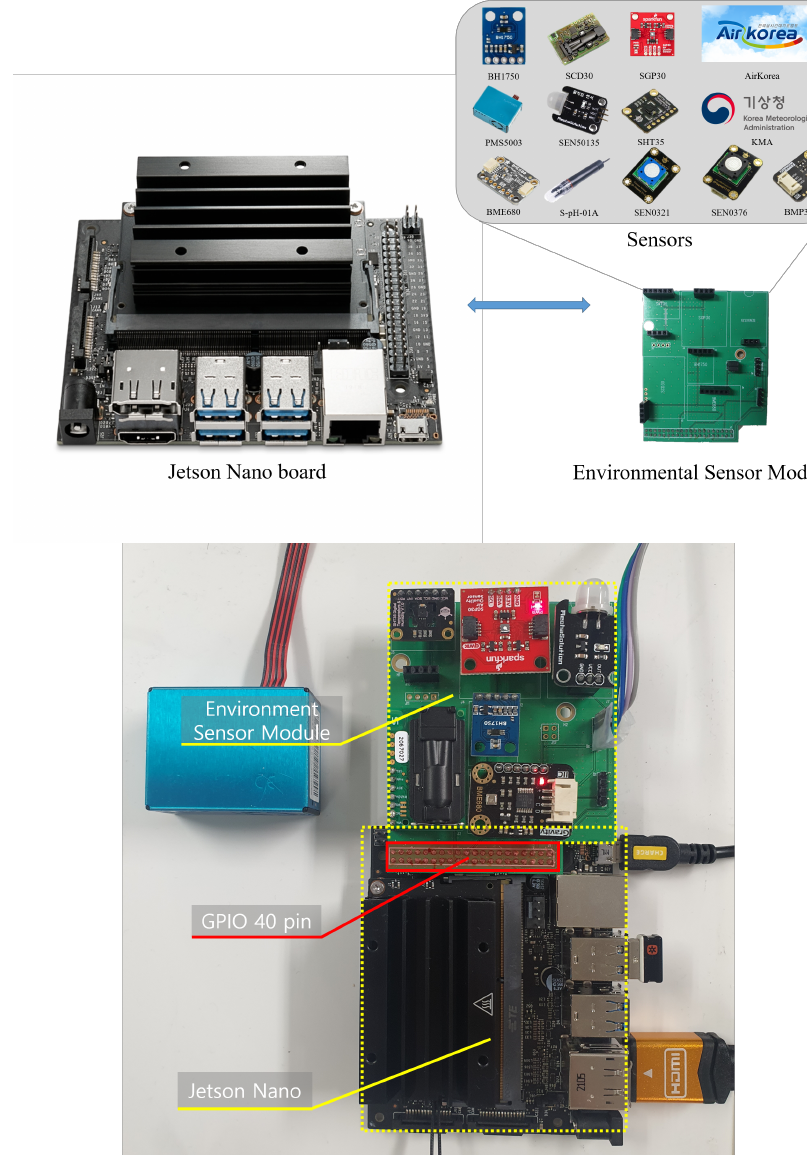
Figure 3. Designed environment sensor